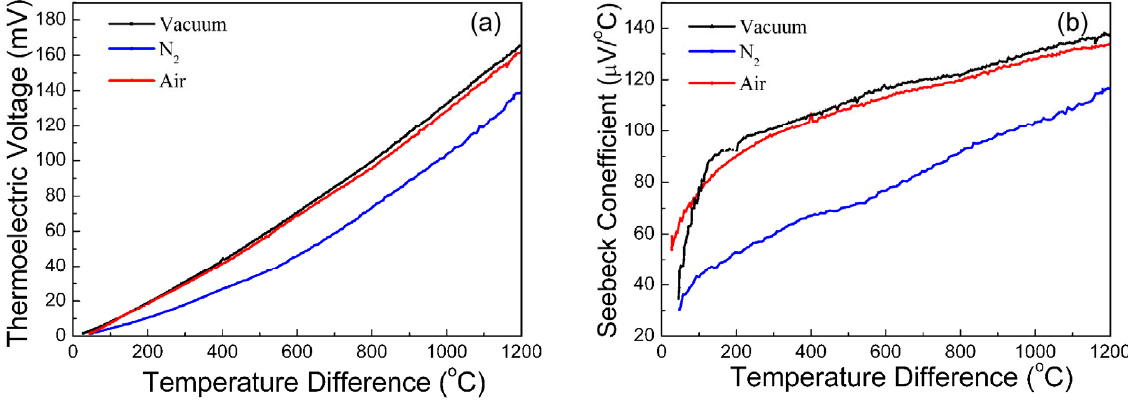
Figure 9. Thermoelectric output curve and Seebeck coefficient change of In 2 O 3 /ITO thermocouple under different atmospheres. ( a ) Thermal voltage output; ( b ) Seebeck coefficient.